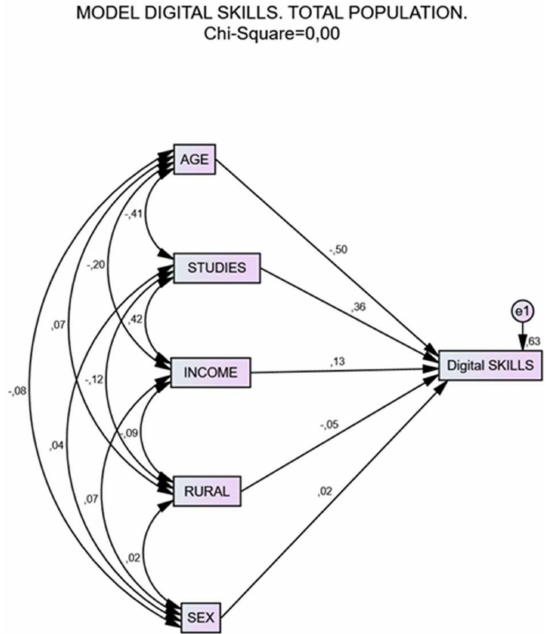
Figure 3. Digital Skills Total Population Model.